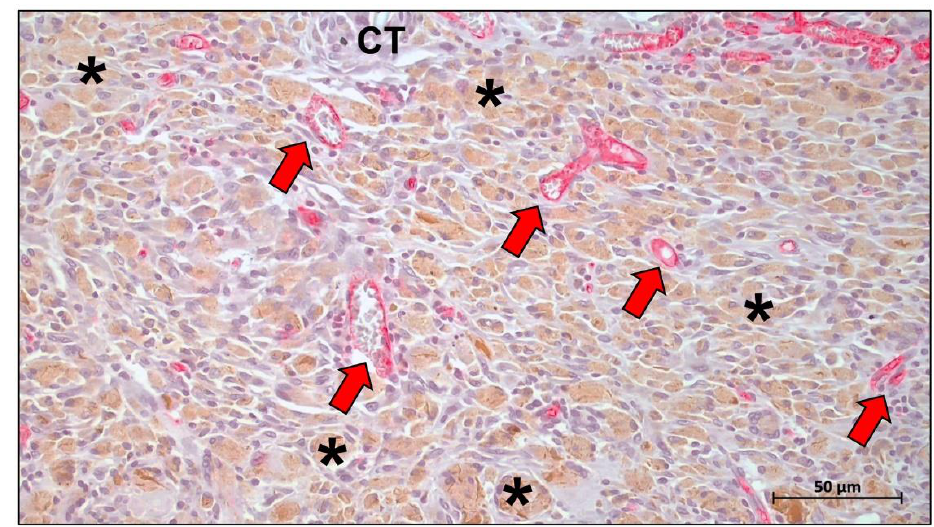
Figure 12. Representative histological image showing vessel ingrowth (red arrows and red staining) into a dermis-derived collagen membrane (brown staining and asterisks) at 30 days post implanta- tionem. CT = connective tissue (CD31 immunostaining, 200× magnification, scalebar = 50 µm).